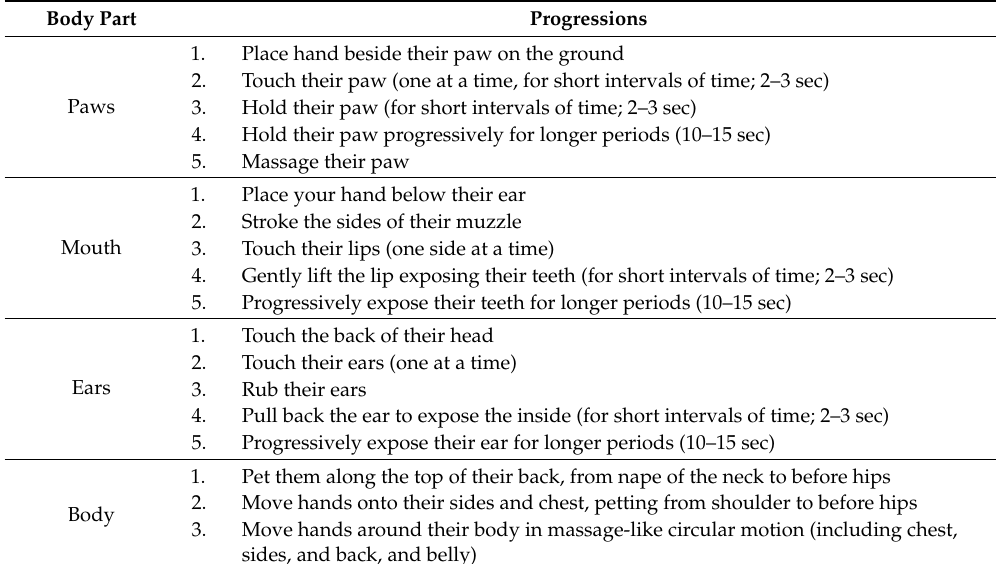
Table 2. Suggested handling progressions for owners to use during training, with the instruction to begin with the body part the dog is most comfortable with and to only proceed to a more advanced progression when the dog is